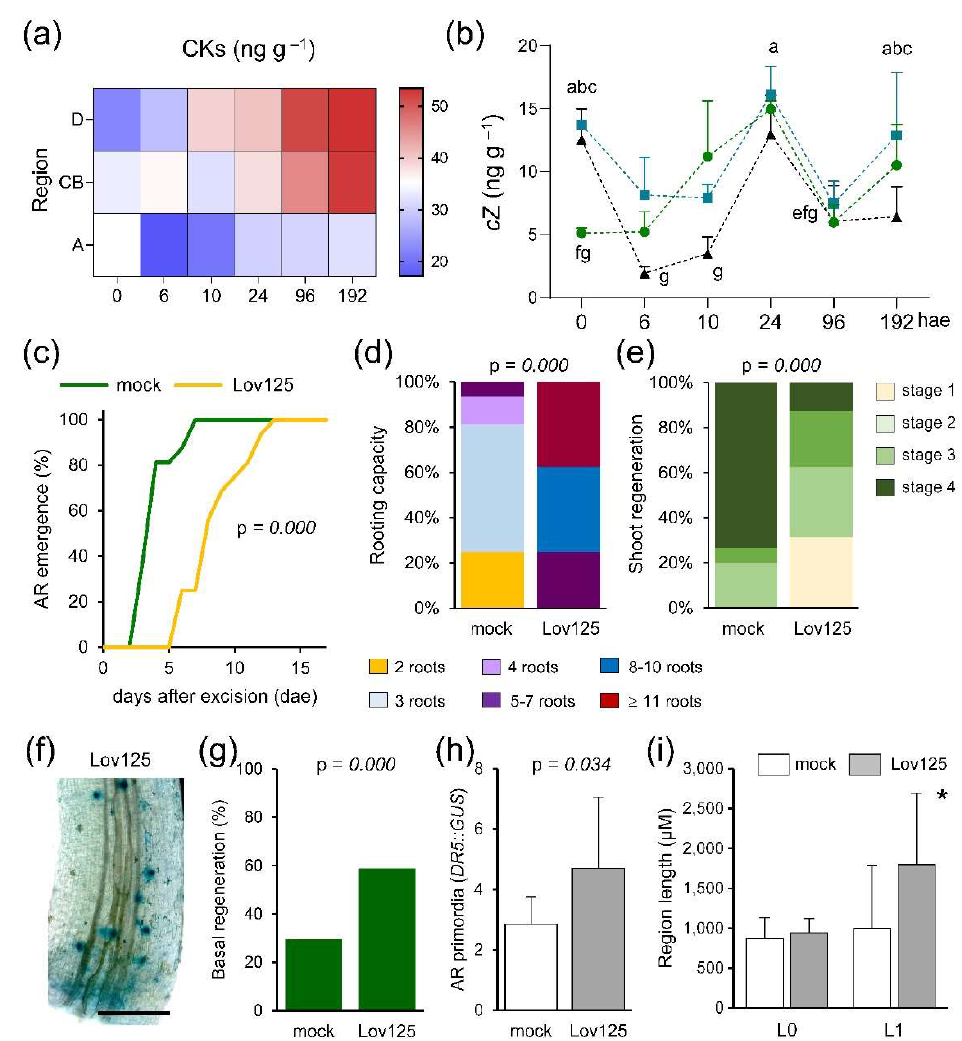
Figure 6. Regulation of CK pathway during de novo organ formation. ( a ) CK profile during the studied time course. ( b ) Endogenous levels of cis- zeatin ( c Z) during the studied time course. ( c ) AR emergence of the studied explants in response to the indicated treatment; Lov125: 125 µ M lovastatin added to the growing medium. ( d ) Rooting capacity of ‘Micro-Tom’ explants at 17 dae. ( e ) Shoot regeneration stages of ‘Micro-Tom’ explants at 17 dae. ( f ) Representative image of DR5::GUS expression in the hypocotyl explants at 48 h after 125 µ M lovastatin (Lov125) treatment. ( g , h ) Regeneration response ( g ), and AR primordia expressing DR5::GUS ( h ) at 48 h after mock or Lov125 treatment. ( i ) Length of the distance to the wounding (L0) and of the AR formative region (L1) at 48 h after mock or Lov125 treatment. Different letters ( b ) and asterisks ( i ) indicate significant differences ( p -value < 0.05) between the studied regions in whole hypocotyl explants. Scale bars in f: 1